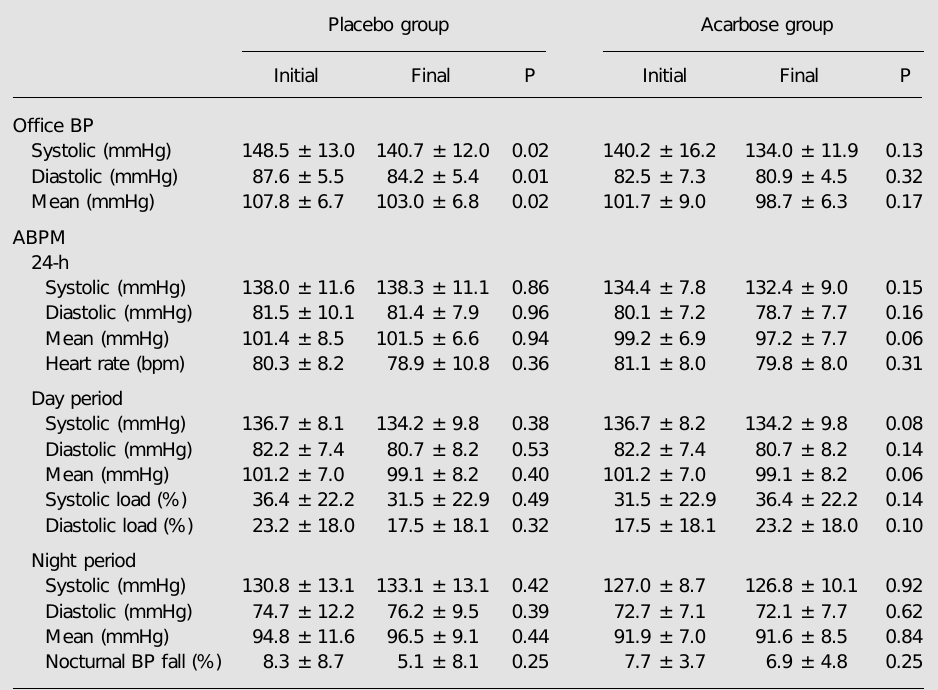
Table 3. Hemodynamic data obtained before randomization and at the end of the treatment period. Placebo group Acarbose